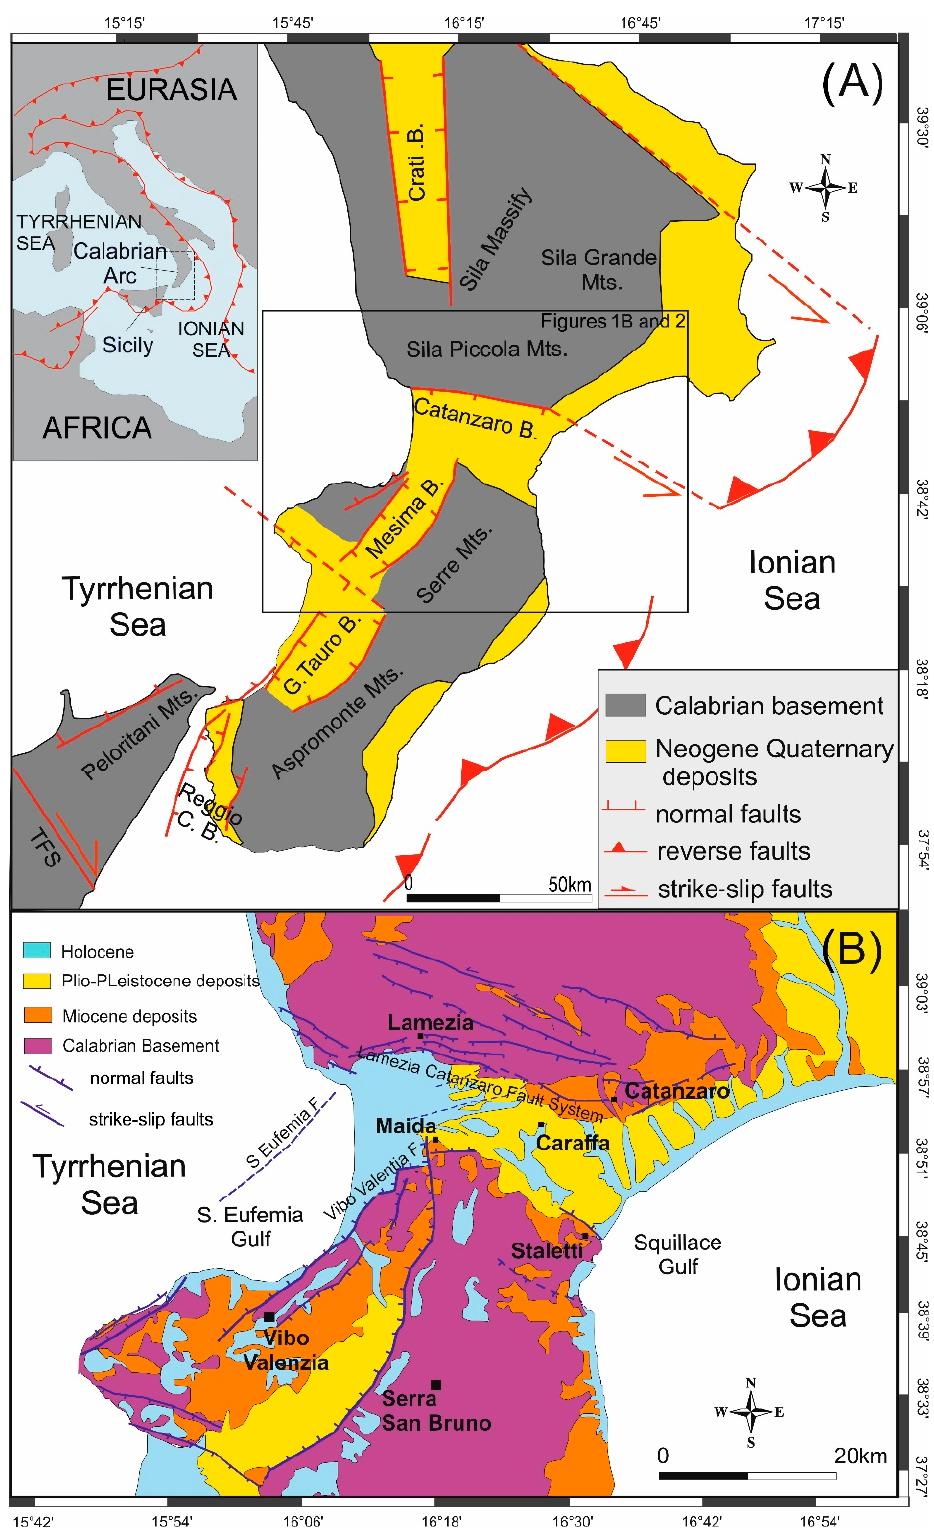
Figure 1. ( A ) Simplified geological map of the Calabrian Arc with the main structural elements from Van Dijk et al. [17] and Ghisetti [18,19]; TFS is the Tindari Fault System. Inset shows the Alpine ‐ Apenninic ‐ Maghrebian orogen in the context of the Eurasia ‐ Nubia convergence; ( B ) Geological sketch map of the Central Calabria.